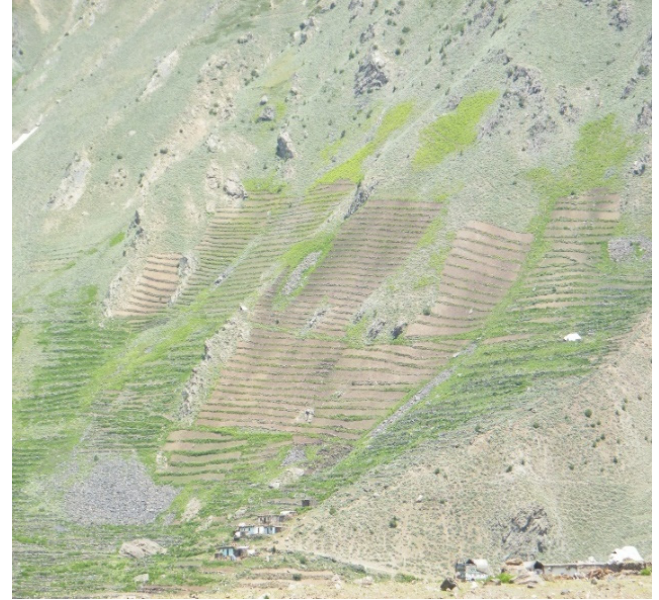
Figure 5. Weeds and invasive shrubs on agricultural land.